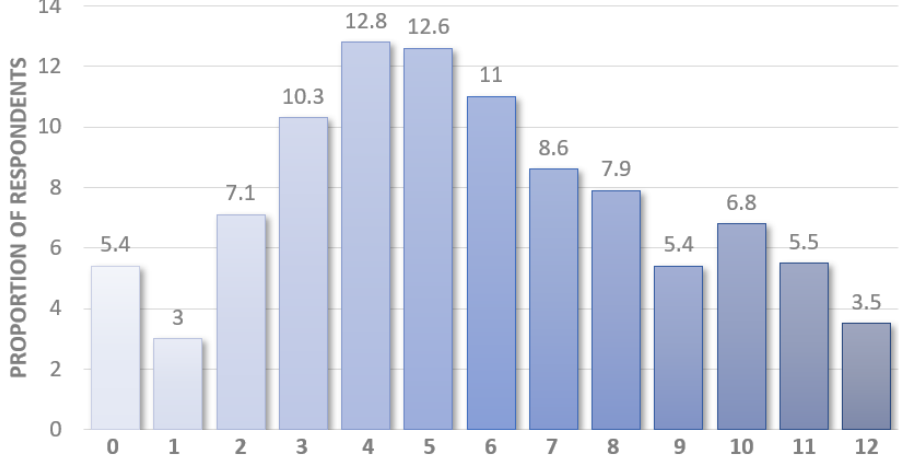
Figure 1. The proportion of respondents who correctly identified the number of risk and protective dementia factors (out of 12).